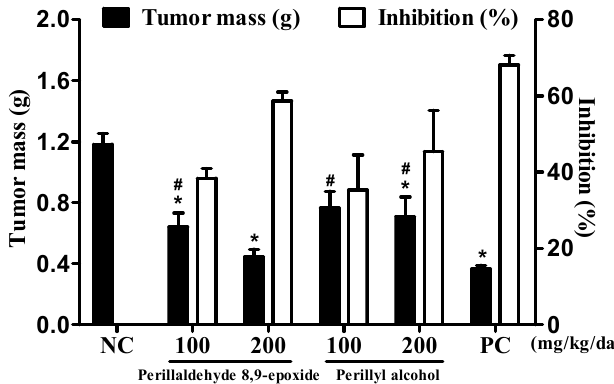
Figure 2. The antitumor activity of perillaldehyde 8,9-epoxide and perillyl alcohol on animals inoculated with sarcoma 180 tumor cells (S-180). The graphs show tumor mass (g) and tumor growth inhibition rate (%). Administration of the compounds was performed intraperitoneally, at doses of 100 and 200 mg/kg/day, starting 24 h after the inoculation of S-180, during 7 consecutive days. As a positive control (PC), we used 5-Fluorouracil (25 mg/kg/day, i.p.). As a negative control (NC), we used 5% DMSO. Data are presented as mean ± SEM ( n = 10 animals/group). * p < 0.05 compared with the NC group, and # p < 0.05 compared with the PC group by variance analysis, followed by the Student-Newman-Keuls test.